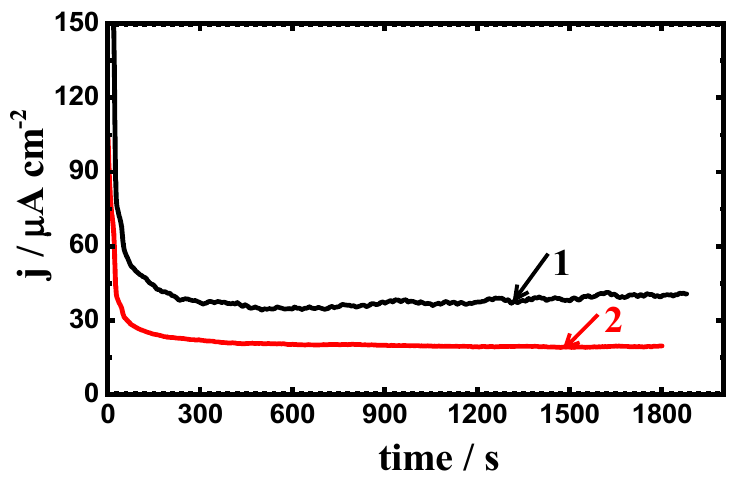
Figure 11. The obtained current vs. time curves at − 700 mV for ( 1 ) API-2H steel and ( 2 )